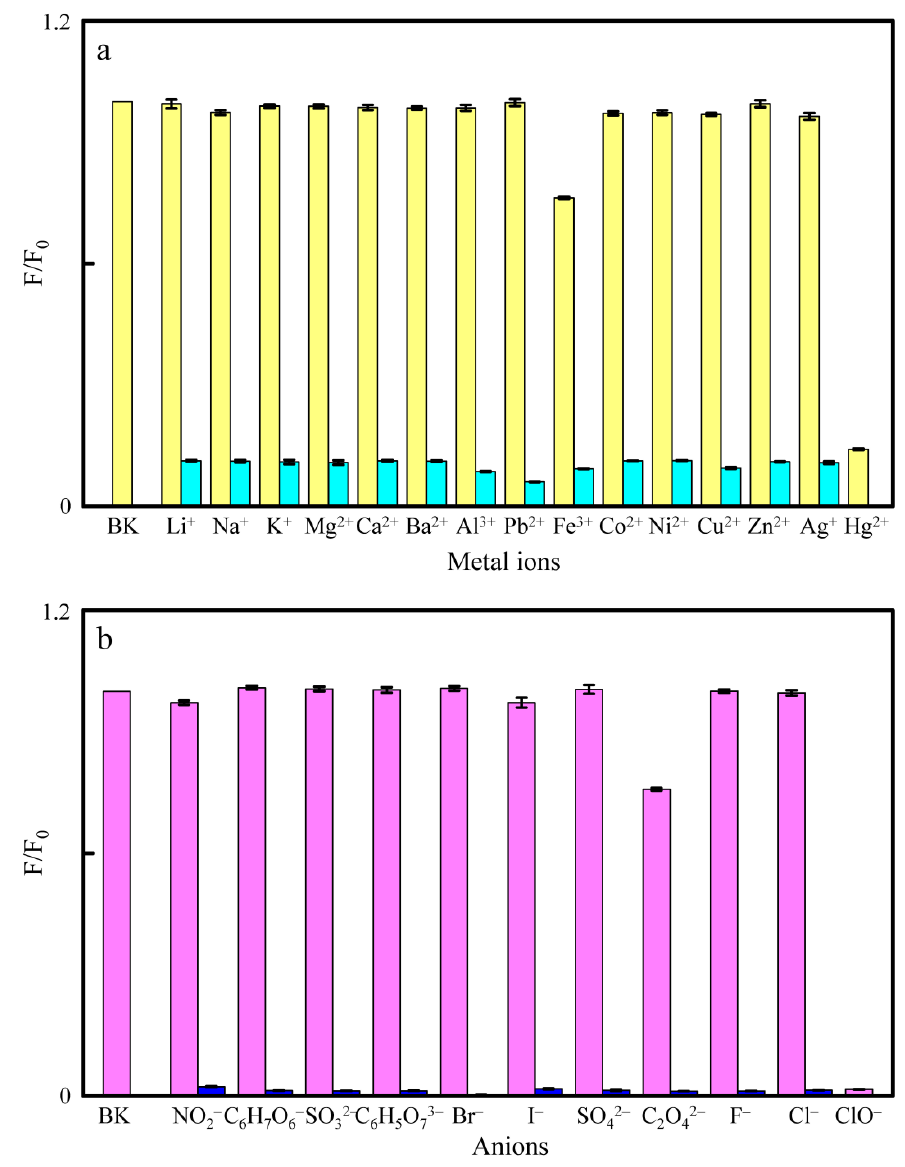
Figure 5. ( a ) The corresponding fluorescence intensity before (yellow) and after (cyan) the treatment of Hg 2+ . ( b ) The corresponding fluorescence intensity before (pink) and after (blue) the treatment of ClO − .